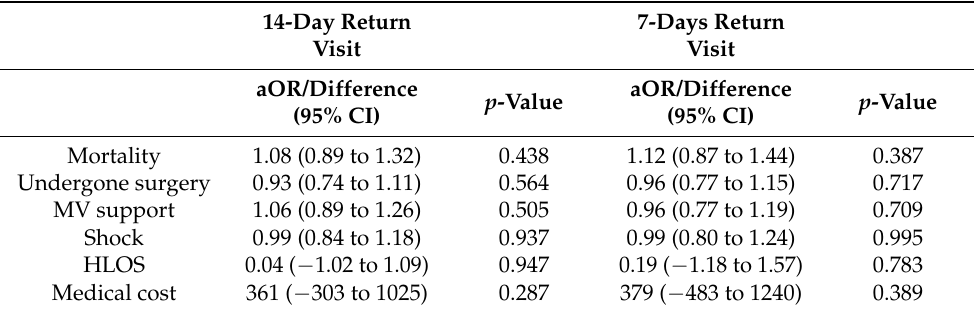
Table 2. Regression analysis of ICU admission following return ED visit with respect to in-hospital outcome and medical